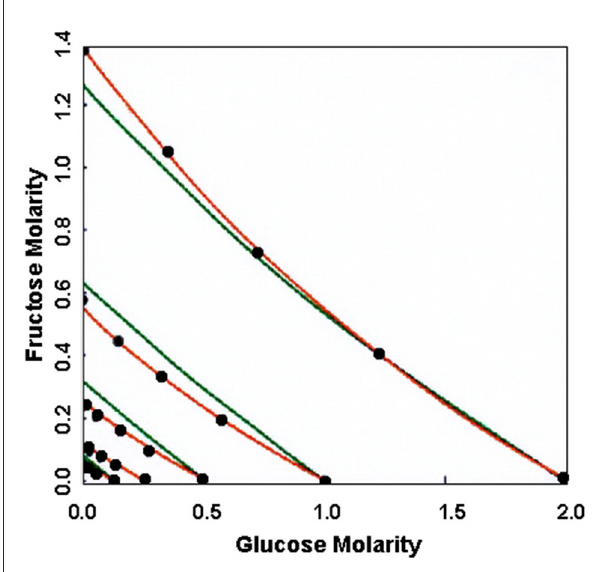
FIGURE1 Plots of the concentrations of glucose and fructose in mixtures that are equally sweet to target concentrations of glucose alone (the black dots). Also shown are the fits of the models given in Table 1 for the independent receptor model (shown in green) and the independent receptor-transducer model (shown in red). The data were obtained from DeGraaf and Frijters (1986) and the fit of the models from Ennis